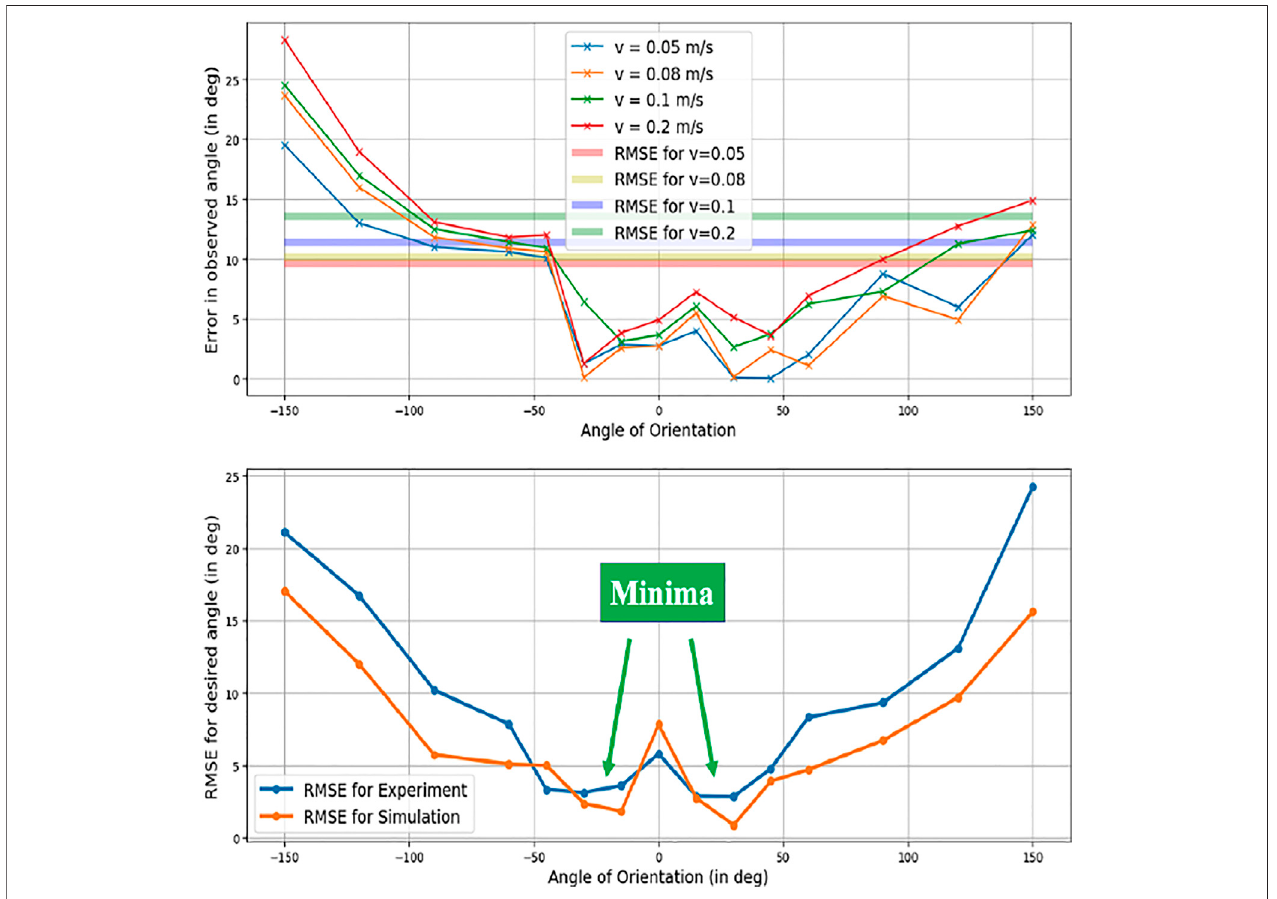
FIGURE 11 | Error plot of directional